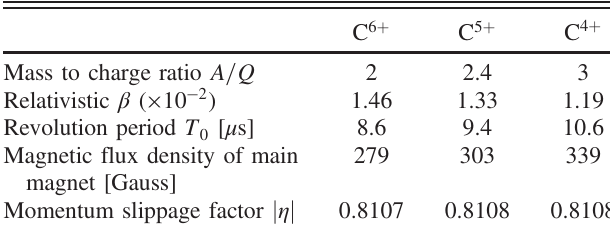
TABLE II. Beam and machine parameters.